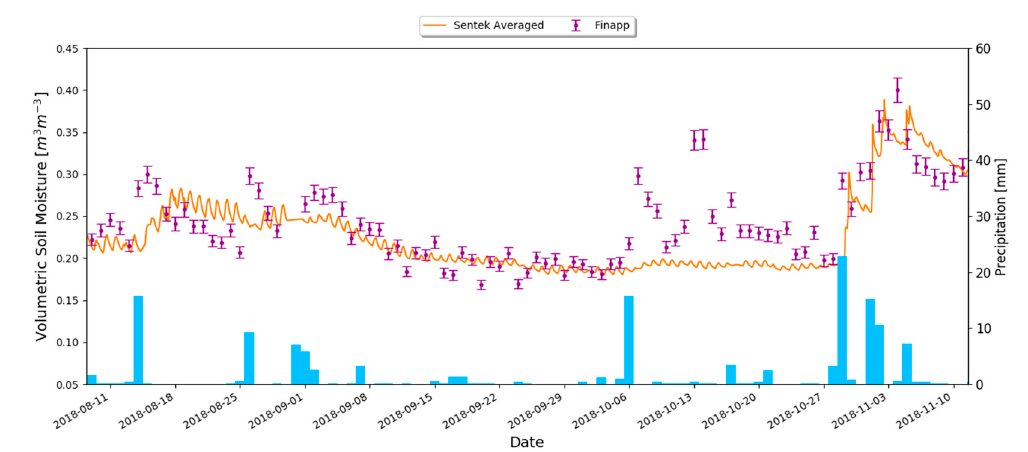
Figure 9. Volumetric soil moisture from Finapp (magenta) and average soil moisture from Sentek (orange); for details see the text. Daily rain is reported in the bottom part of the plot.